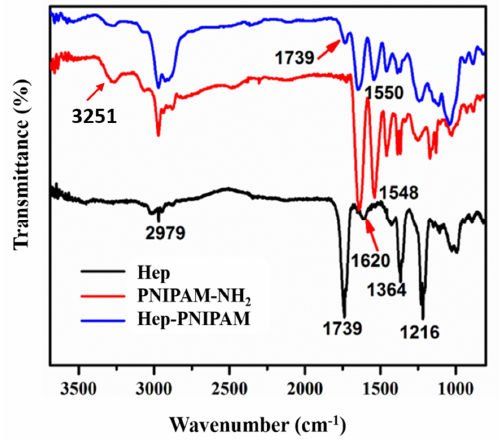
Figure 1. FTIR spectrum of heparin (Hep) (black), amino-terminated poly( N -isopropylacrylamide) (PNIPAM-NH 2 ) (red), and Hep-PNIPAM (copolymer) (blue). Polymers 2020 , 12 , x FOR PEER REVIEW